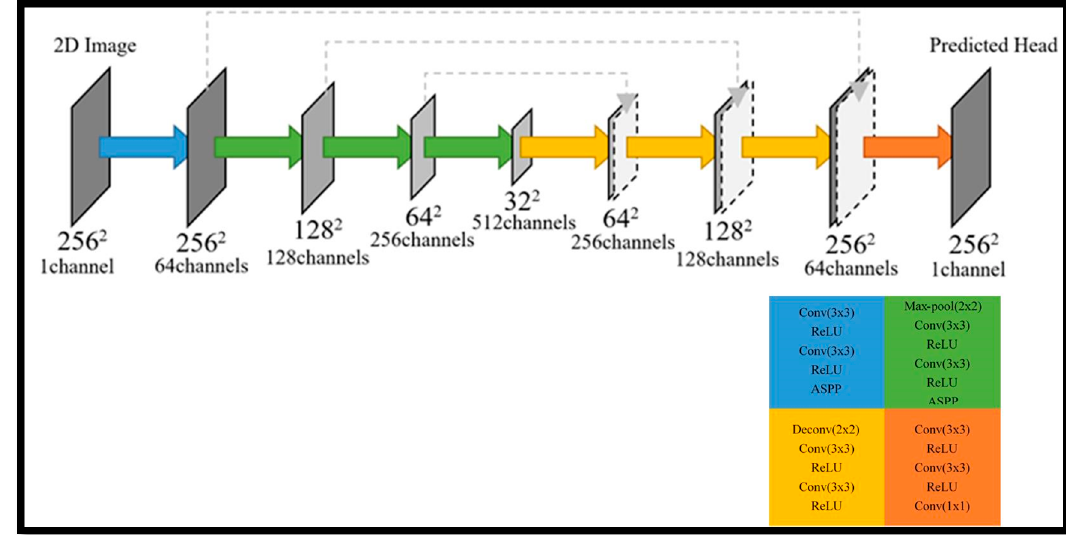
Figure 2. Illustration of Unet + ASPP architecture.